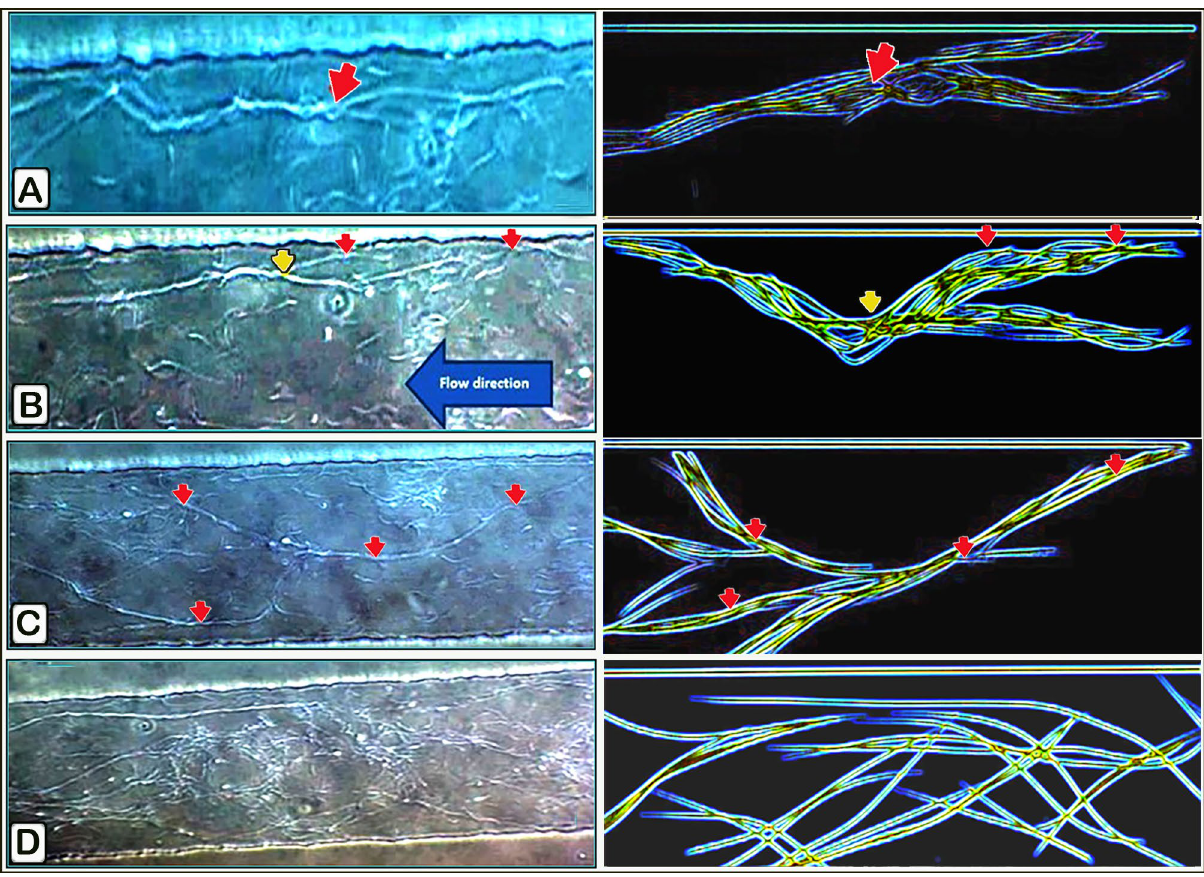
Figure 2. Bundle interconnections and attachments to the walls. Video taken from phase contrast microscope. Images from phase-contrast microscopy and drawings accompany each image for presentation. ( A ) The connection between two threads by spiral movement to resist the flow (red arrow). ( B ) Attachment between the bundles and wall of the channel (red arrow); at the same time, they are connected to two other bundles (yellow arrow). ( C ) Sperm bundles inside the microfluidic channel start to be connected (red arrows) with each other, making a net of sperm bundles. ( D ) The formation of a network of sperm